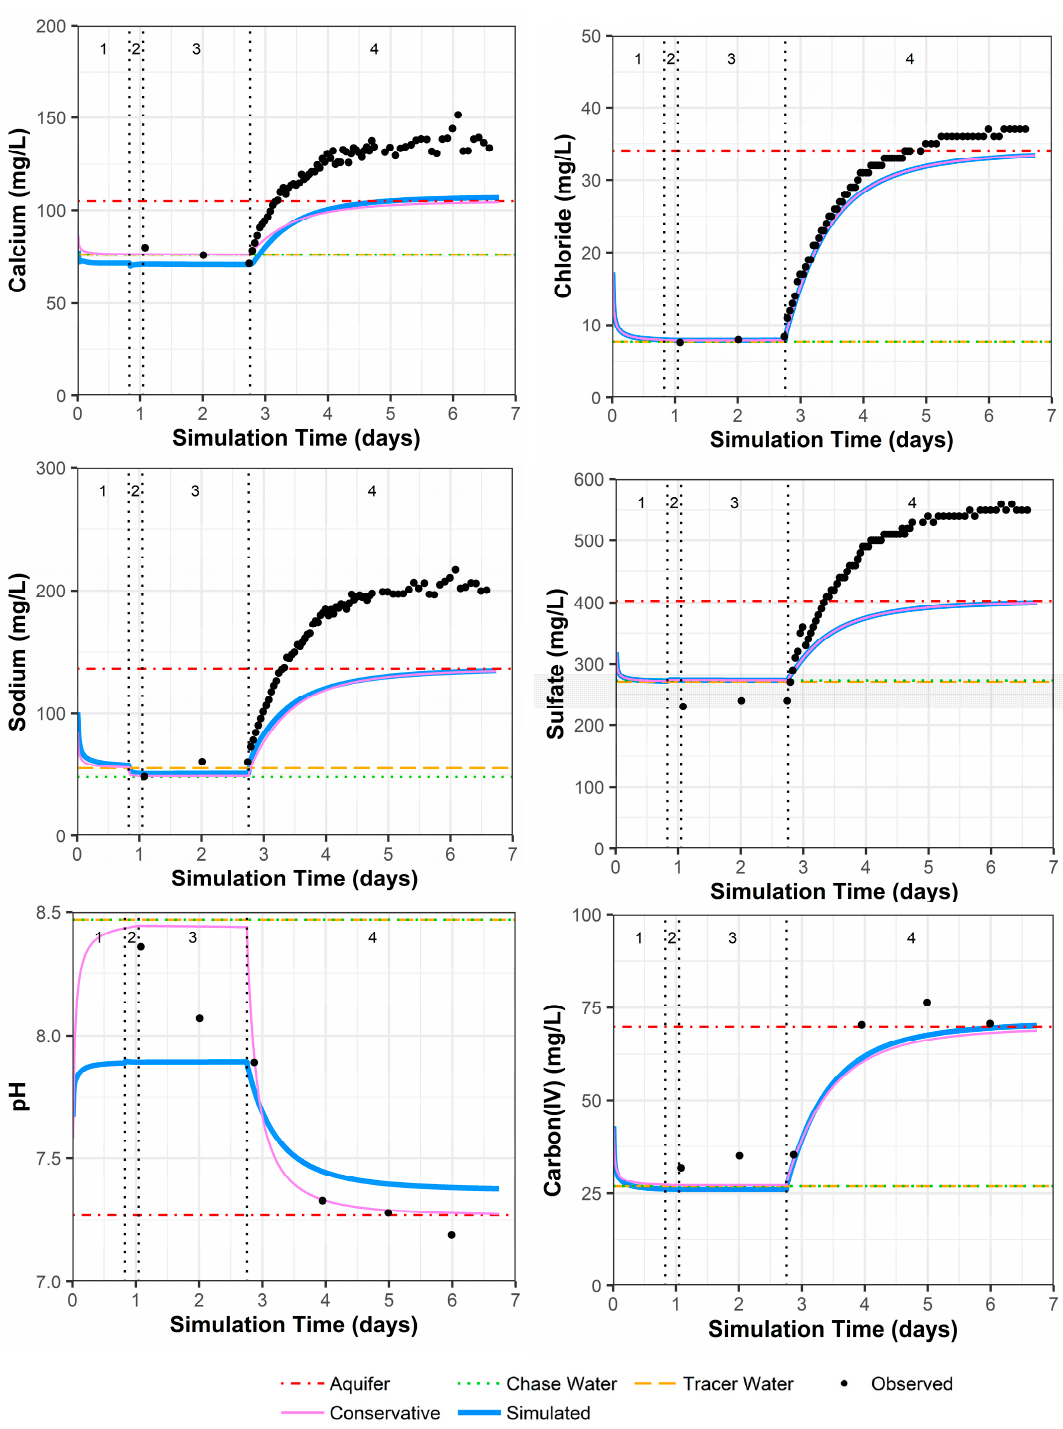
Figure 6. Model fit for various constituents in well 0106 with a multilayer approach. Phases are: (1) traced river water injection, (2) untraced river water injection (chase), (3) drift phase, and (4) pumping phase.